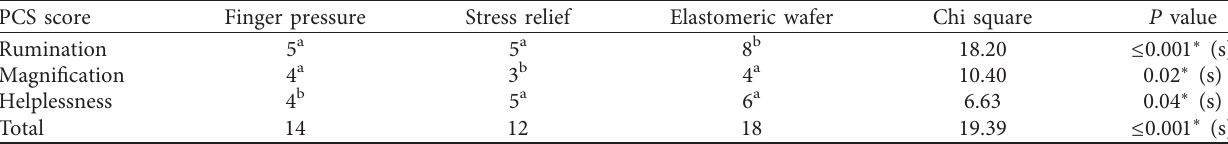
Table 2: Descriptive statistics for PCS scores.